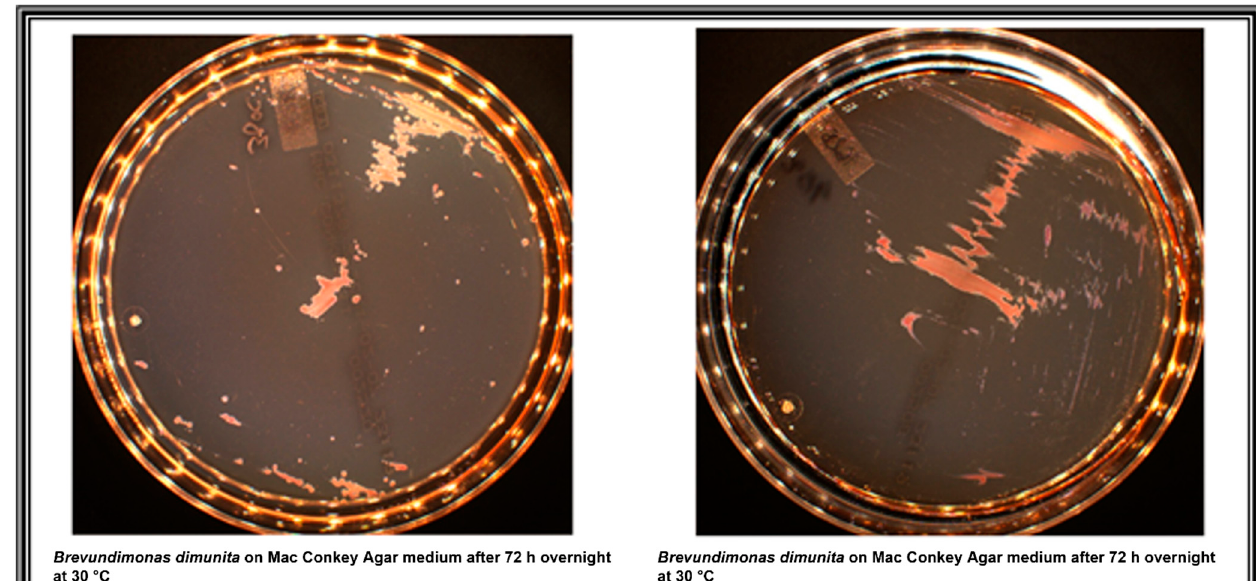
Figure 1. B. diminuta on Mac Conkey agar medium.